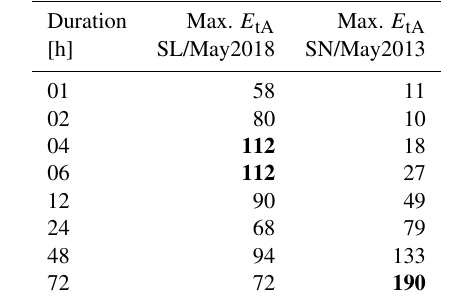
Table 2. Maximum E tA values for all considered durations. The WEI of this event (the maximum E tA value regarding all durations) is in